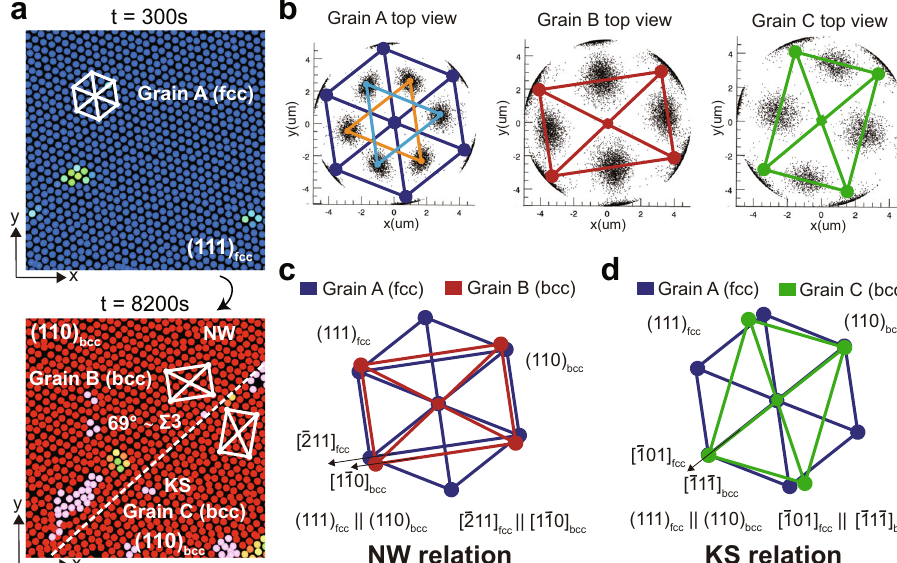
Fig. 3 Examples of bcc twinning grains in the product bcc solid. a Creation of the bcc twinning grains B and C from fcc grain A (the inside-grain nucleation). Colour represents the value of W 6 . Pink particles are defect clusters with Q 6 < 0.35. b Representation of the orientational relationship by the bond orientational diagram of each grain. c The NW relationship between fcc grain A and bcc grain B. d The KS relationship between fcc grain A and bcc grain C. The twinning boundary between grains B and C forms with a tiny angle rotation of the C AOT -dependence of the shear modulus component C fcc and C bcc in 44 44 Fig. 1c (see ‘ Methods ’ for C 44 de fi nition and measurements). We can use this property to probe how the lattice softness affects the microscopic kinetics. At each C AOT , we estimate the effective temperature T in units of the melting temperature T m of the bcc lattice, using the Lindemann criteria: T ~ δ L 2 ( C AOT ) T m / δ L 2 ( C m ), where C m is the AOT concentration close to the bcc melting line at ϕ ~ 22%. Typically, a rapid jump from C AOT = 60 mM, where fcc is stable, but a small amount of pre-existing bcc exist, to C AOT = 10 mM (indicated by the orange arrow in Fig. 1b), where bcc is stable, produces a weak-driving force of the transition at T ~ 0.65 T m (10 mM). On the other hand, a rapid jump from C AOT = 70 mM (fcc-stable, pre-existing bcc is less frequent than at